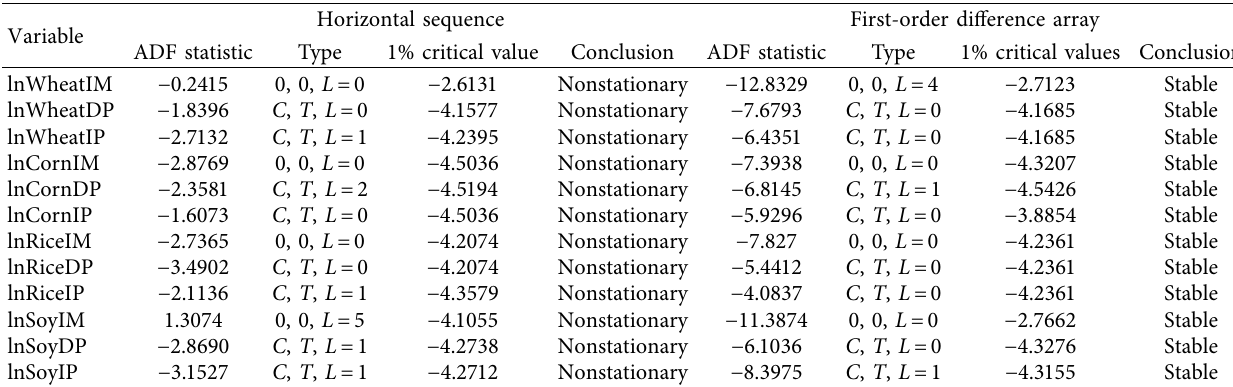
Table 3: Results of the ADF unit root test.